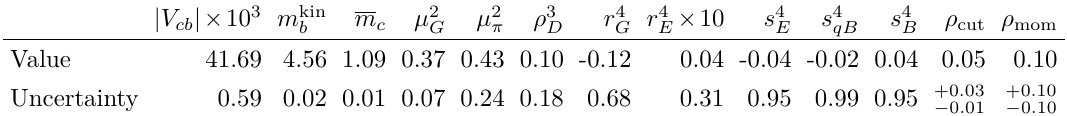
parameters with a standard normal Gaussian constraint. Table 6 . Fit result including all 1 /m 4 b All parameters are expressed in GeV at the appropriate